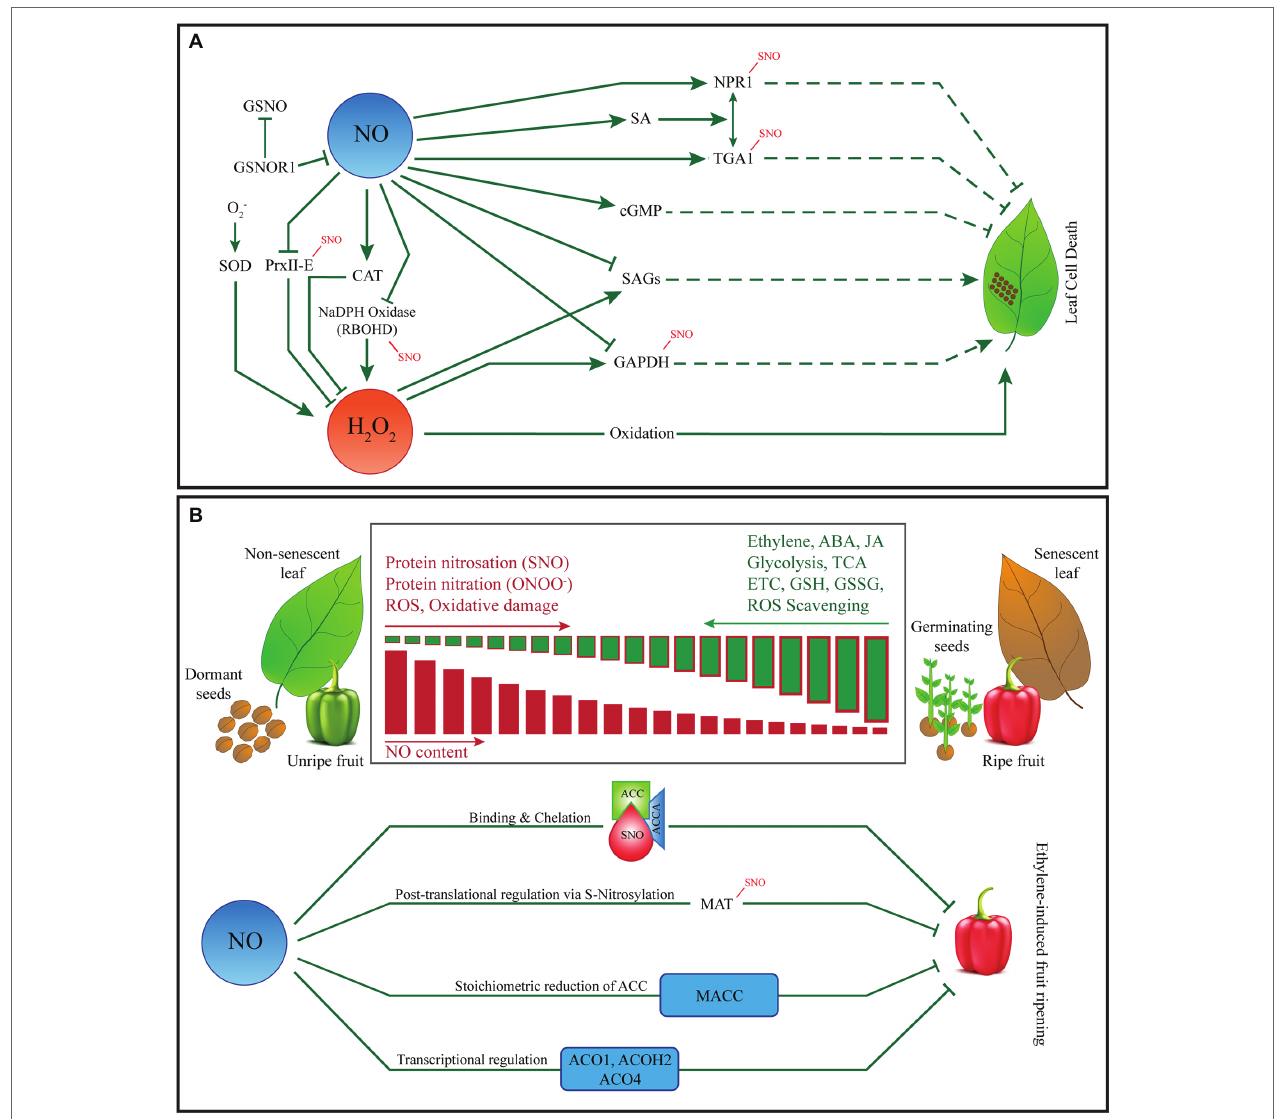
FIGURE 1 | Role of nitric oxide in fruit ripening, programmed cell death and leaf senescence. (A) NO and ROS-mediated control of programmed cell death. Plants rapidly-produce NO and various ROS in response to biotic and/or abiotic stresses leading to intrinsic execution of the target cells. NO and ROS can trigger PCD either synergistically or independently. Both NO and ROS are implicated in the hypersensitive response (HR), characterized by the execution of the infected and surrounding cells, is a well-known form of PCD in plants. However, significant cross-talk exists between NO and ROS during the establishment of HR. The establishment of HR warrants a critical balance between intracellular levels of NO and ROS. Several key proteins such as non-expressor of pathogensi-related genes 1 (NPR1), TGA1 (transcriptional activators that specifically bind to 5 ′ -TGACG-3 ′ ), glyceraldehyde-3-phosphate dehydrorgenase (GAPDH), respiratory burst oxidase homolog D (RBOHD) are involved in HR are known to be S-nitrosated by NO or affected by the NO-ROS cross talk. NO is also known to scavenge H 2 O 2 under certain circumstances thereby protecting plant cells from ROS-mediated damage. (B) NO-mediated regulation of senescence, seed dormancy and fruit ripening. NO affects leaf senescence by modulating phytohormones such as ABA, ET, and JA. Though the role of NO in seed ageing is not well-defined, NO is known to break seed dormancy via stimulation of ET production. NO donors and arginine (Arg) abolishes seed dormancy and stimulates germination whereas, the application of NO scavengers (such as cPTIO, L-Name, and CAN) promotes seed dormancy. NO-mediated removal of seed dormancy and promotion of germination is associated with alternations of nitrated and biotinylated proteins, ABA, JA and protein nitration. NO has also been implicated in fruit ripening. As the fruit ripens, ROS and RNS anabolic vs. catabolic rates change significantly altering the overall nitro-oxidative environment at the cellular level ultimately affecting the NO-dependent S-Nitorsation and Tyrosine Nitration events in fruit. Furthermore, NO mediated binding and chelation, S-nitrosylation of methionine adenosyl transferase (MAT), stoichiometric reduction of ACC and transcriptional regulation of several genes involved in the ethylene pathway plays an important role in fruit